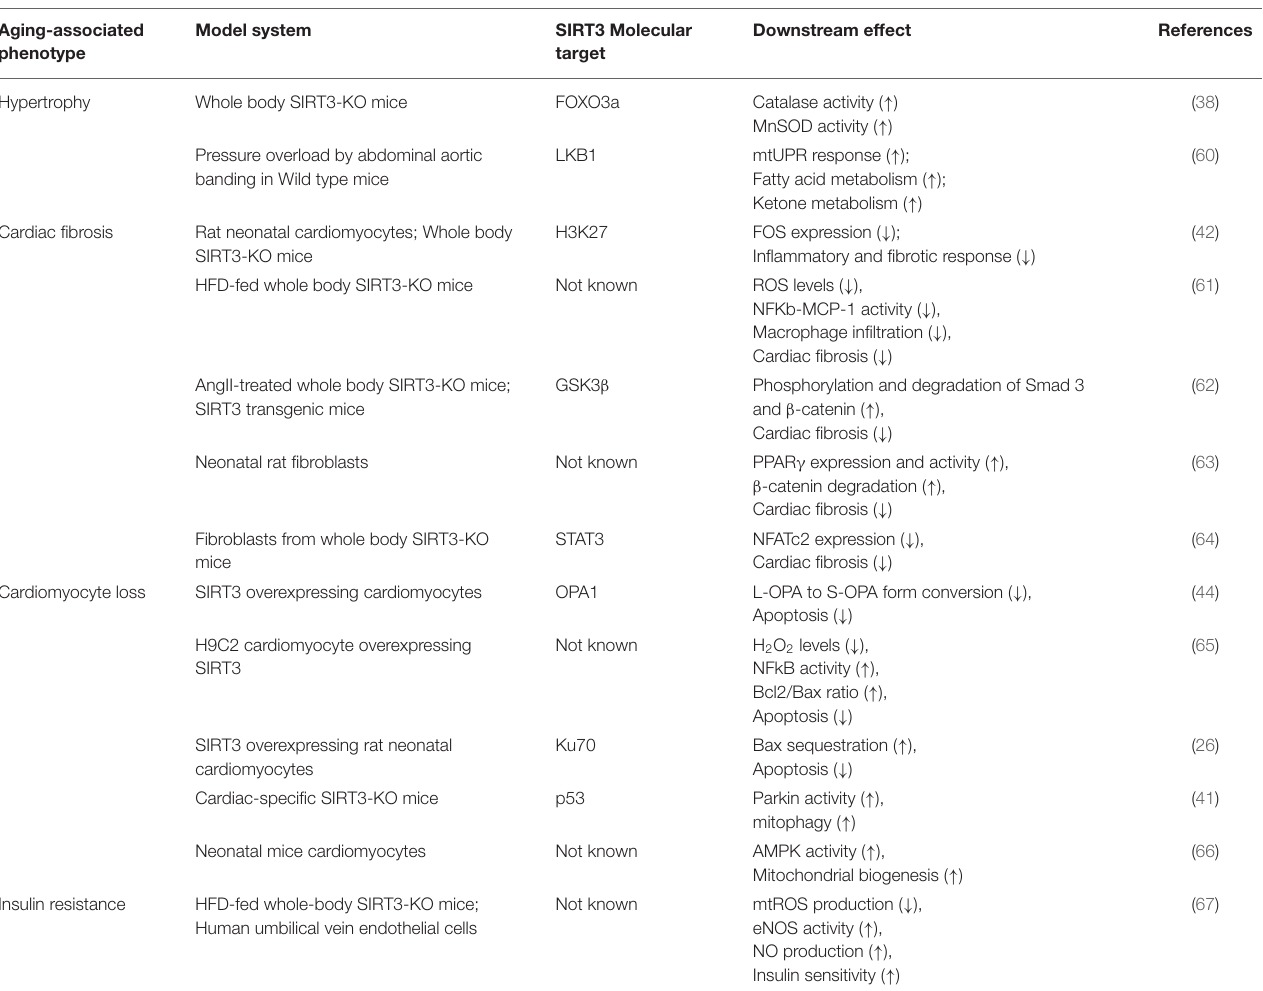
TABLE 2 | SIRT3 targets in aging-associated cardiac